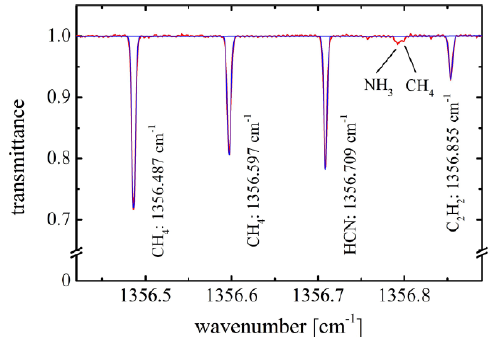
Figure 30. Example of an absorption spectrum at 1356.6 cm −1 with absorption features of CH 4 , HCN, C 2 H 2 and NH 3 ( p = 3 mbar, 10 sccm H 2 + 10 sccm N 2 + 0.5 sccm CH 4 , P screen = 90 W) [63], Reproduced from [63], with the permission of AIP Publishing.